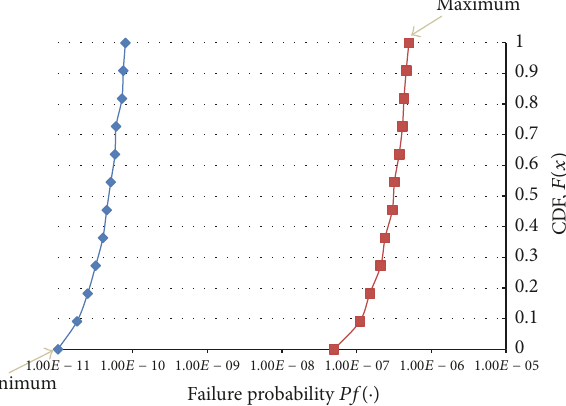
Figure 18: P-box for the response failure